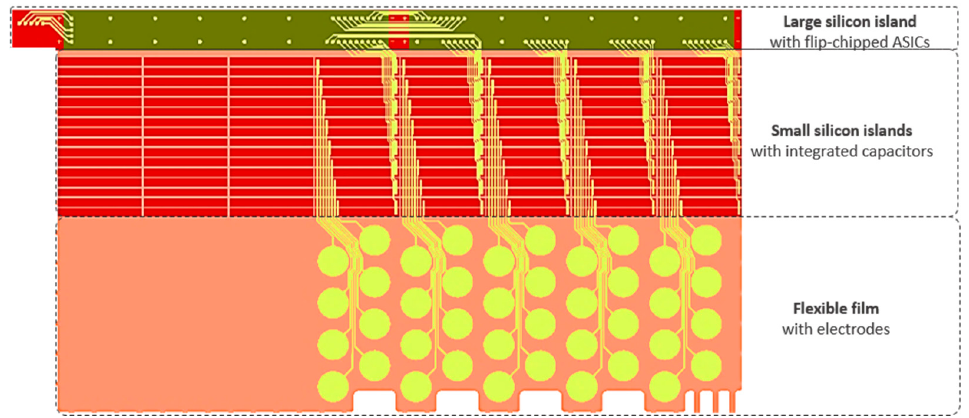
Figure 3. The 2D representation of the 40-electrode DBS design with integrated electronic components. The large silicon island (18 mm × 1 mm) can contain flip-chipped ASICs. The small silicon islands (210 µm × 2070 µm) are separated with 40 µm wide trenches and can accommodate prefabricated decoupling capacitors. The flexible film contains 40 flexible electrodes.